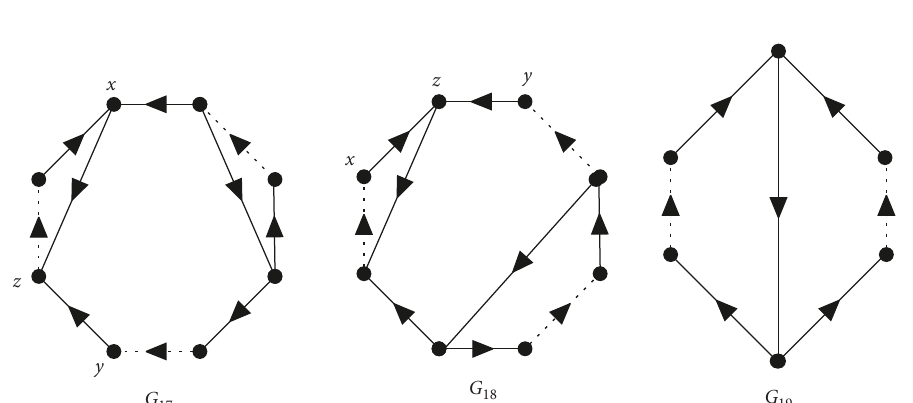
Figure 3: Nonsingular